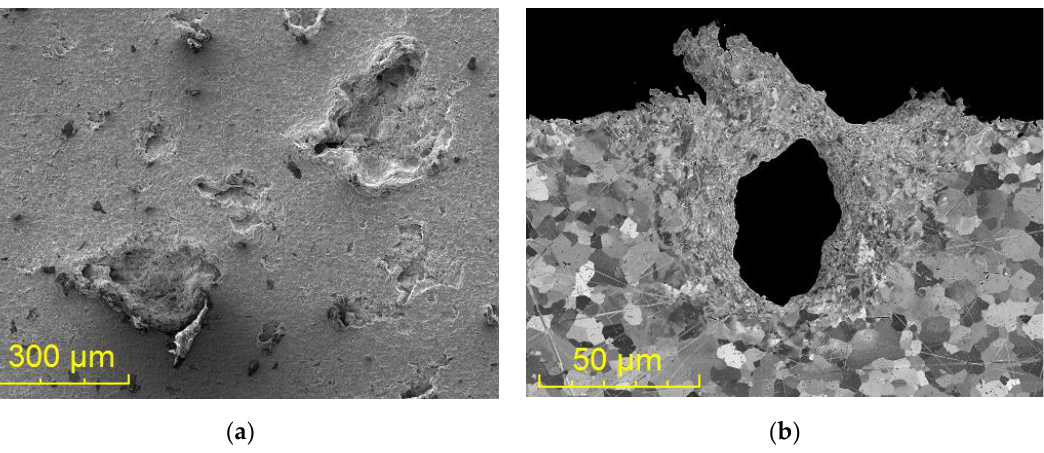
Figure 7. Representative view of destruction of surface ( a ) and near-surface layer ( b ) of 20Kh13 steel under impact for 600 min at d k = 150 µm and S imp = 250 m/s.